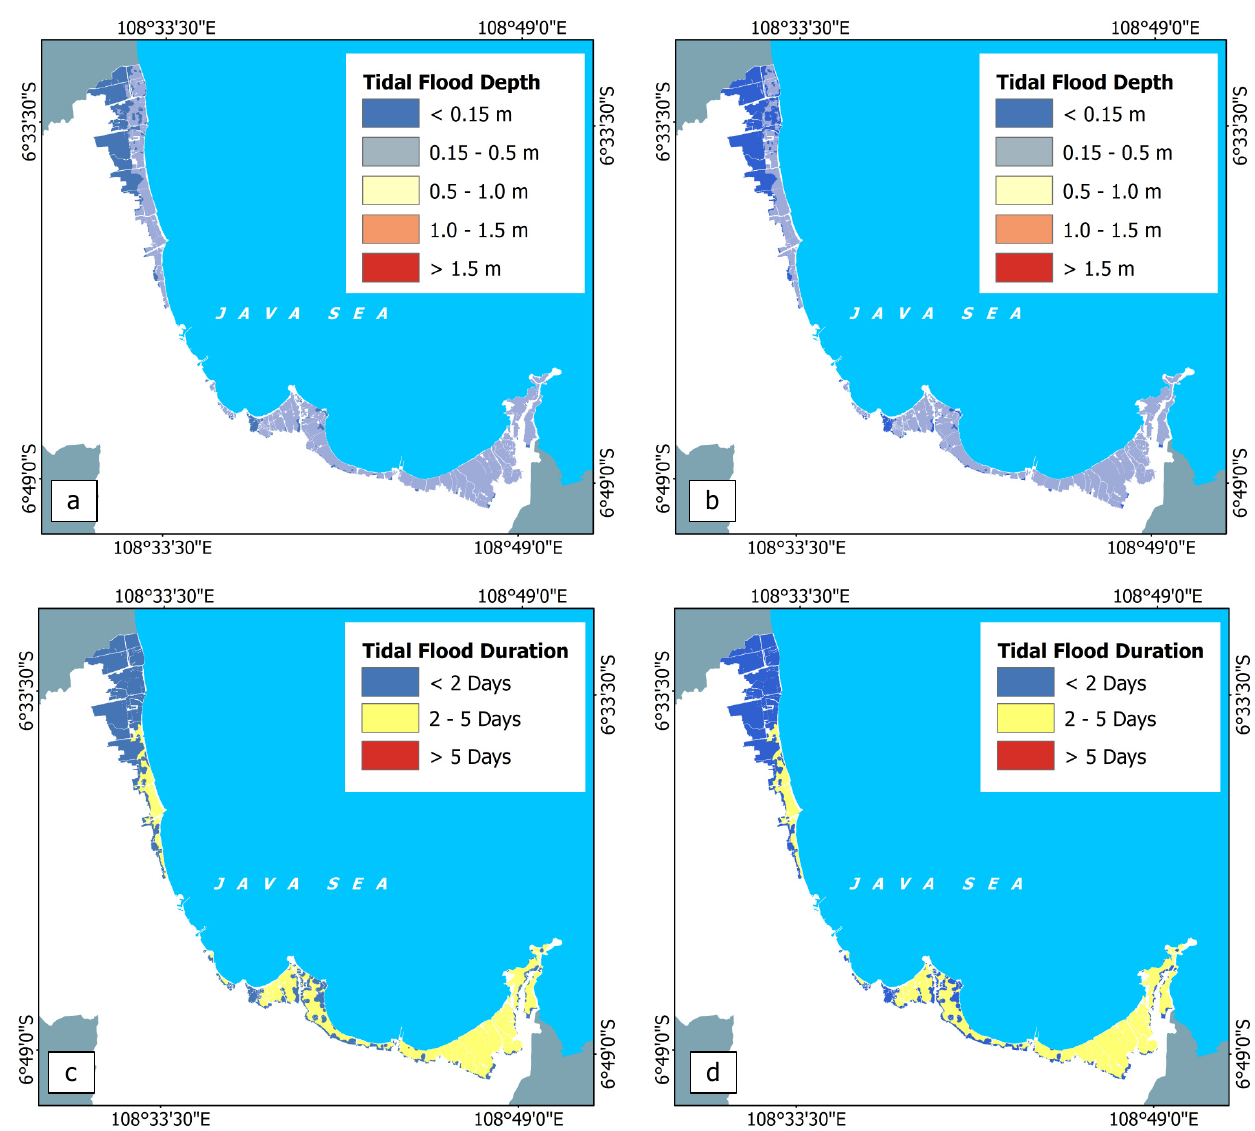
Figure 3. Hazard variables of the current study, including ( a ) flood depth (H 1 ) in 2016 and ( b ) flood duration (H 2 ) in 2016, while ( c , d ) portray the depth (H 1 ) and duration (H 2 ) of the 2018 tidal flood event.